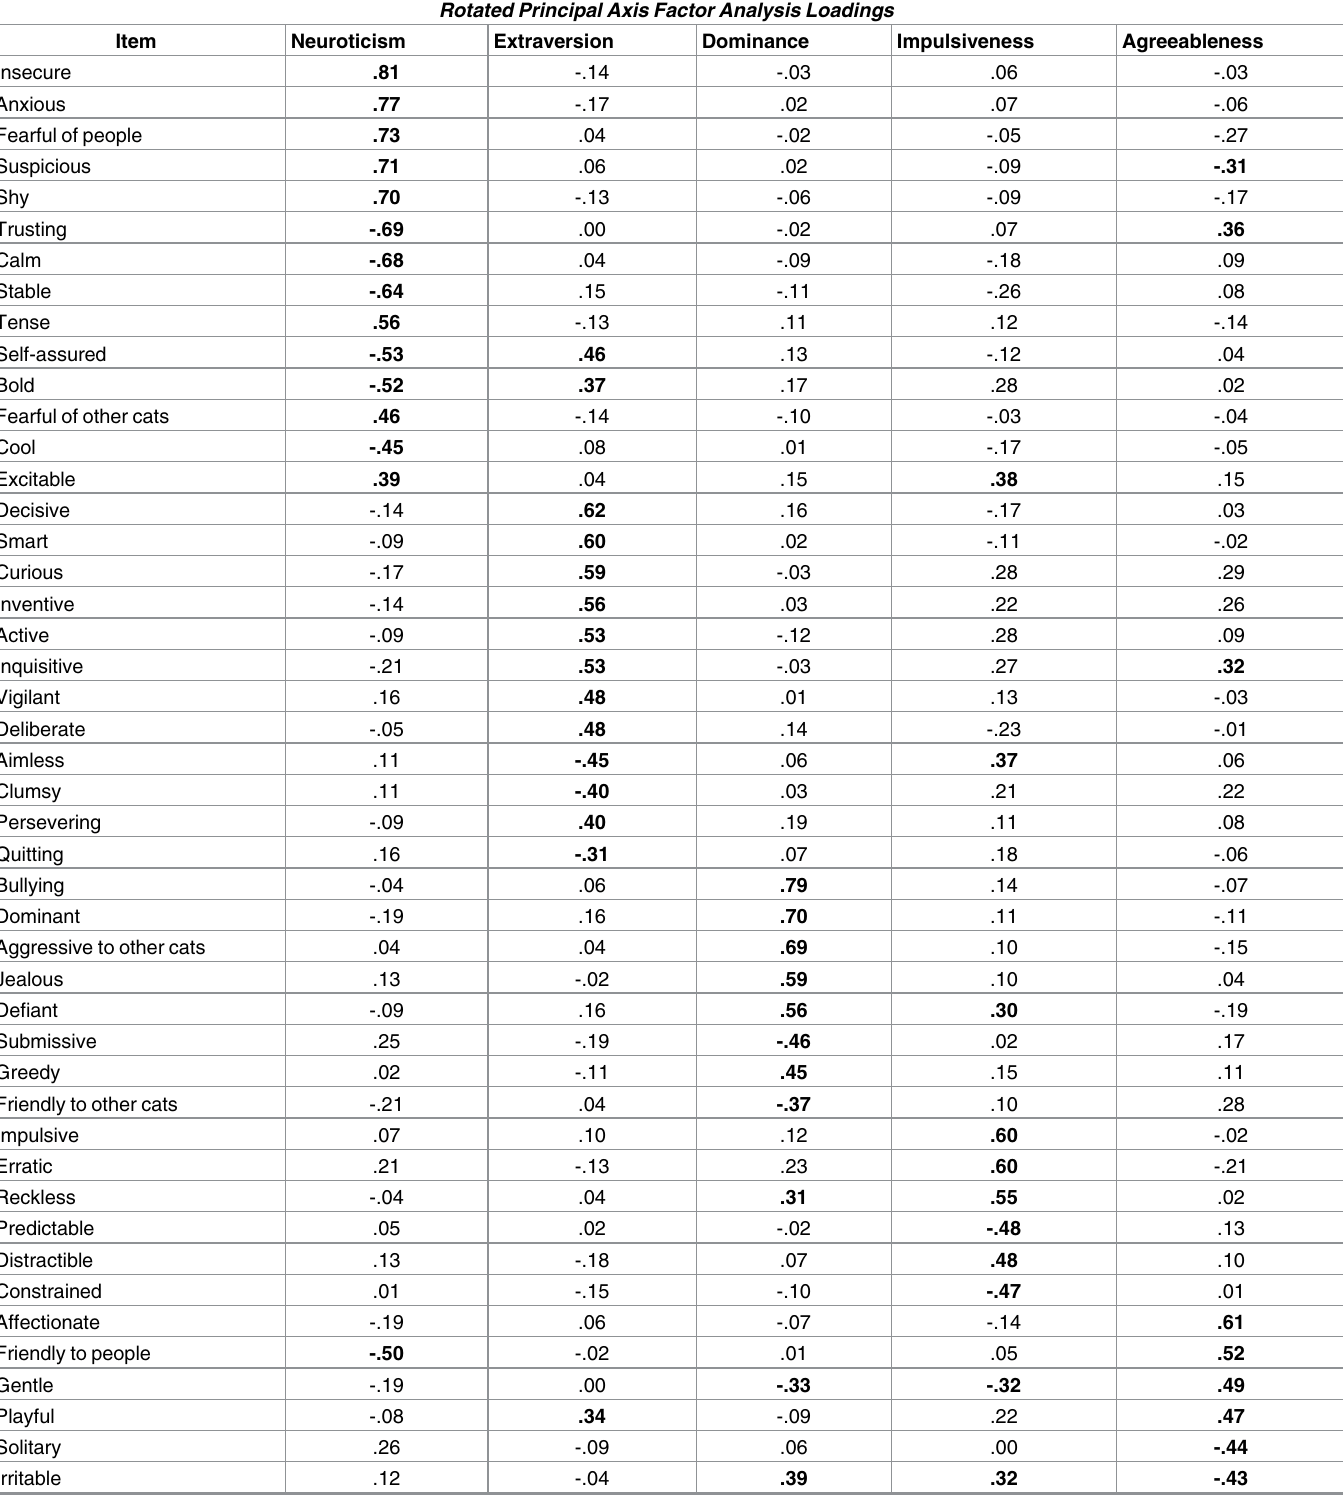
Table 3. Combined South Australian and New Zealand pet cat personality factor structures( n =